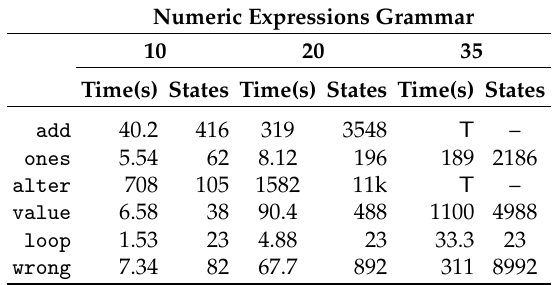
Table 6. Measurements of time and size of state space for analyses of automatically generated